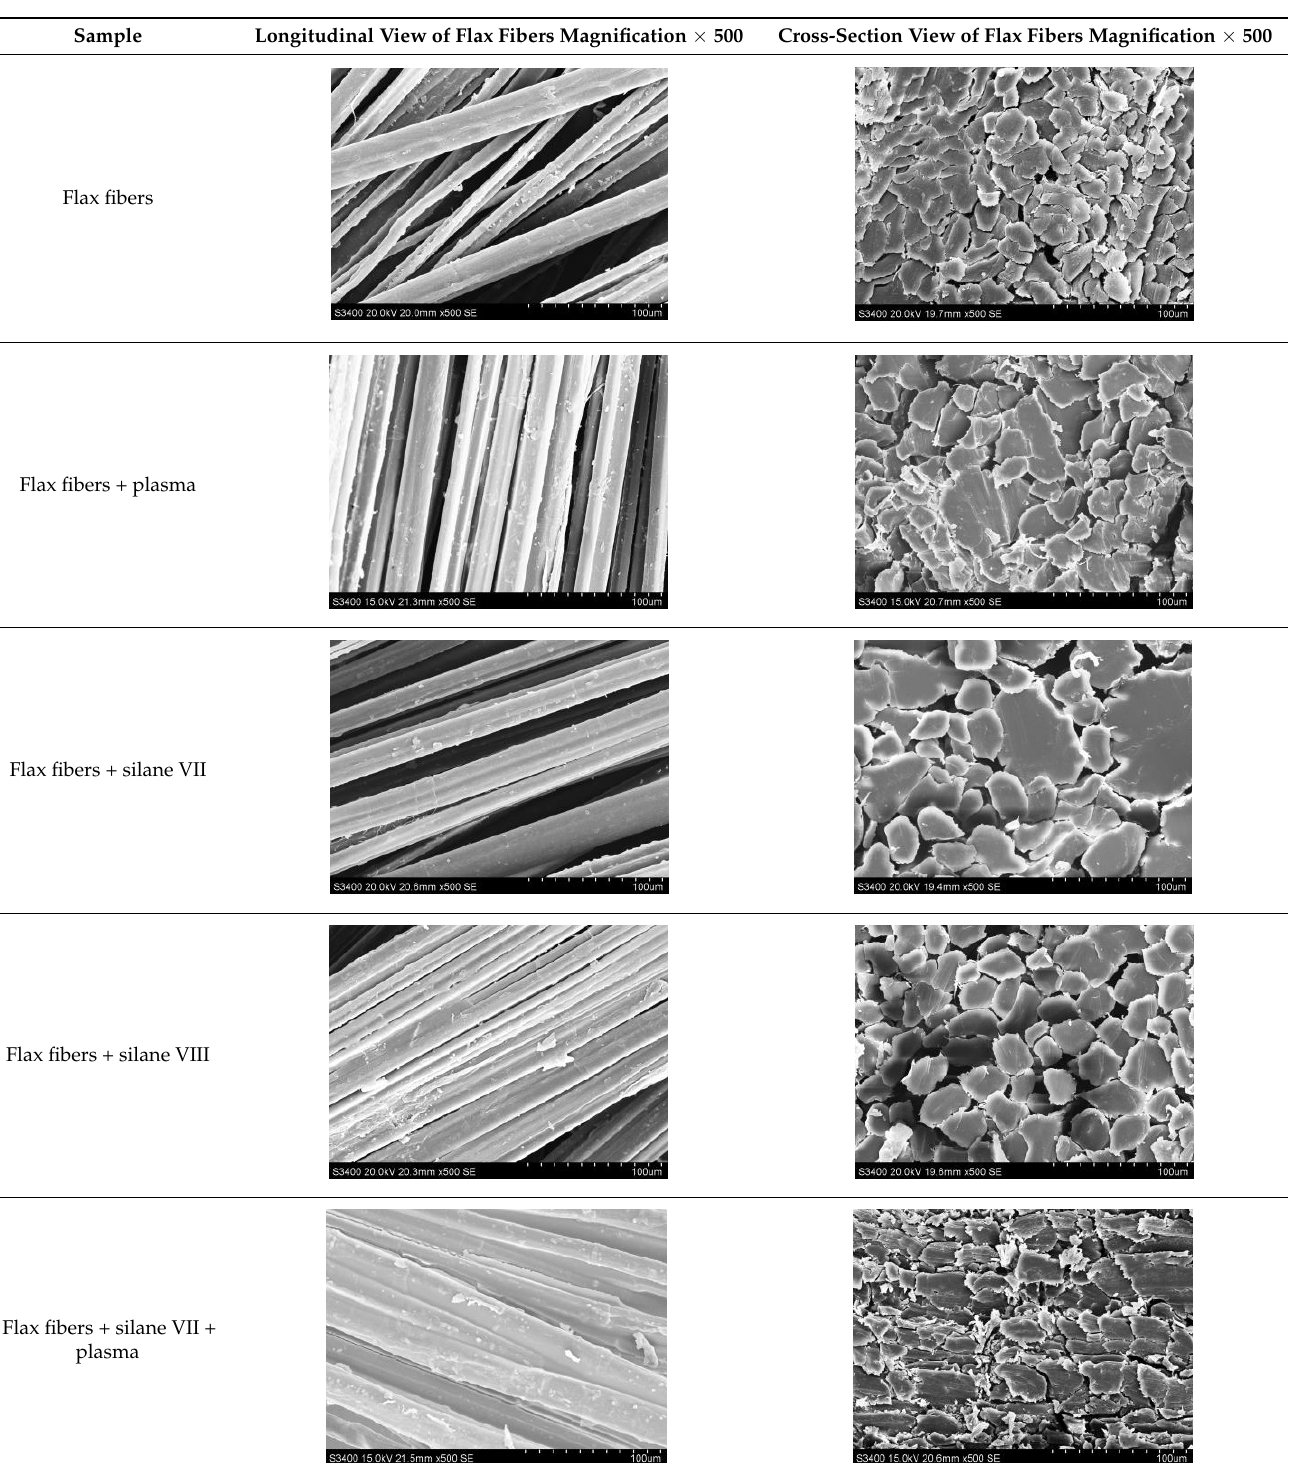
Table 4. SEM of unmodified and modified flax fibers.